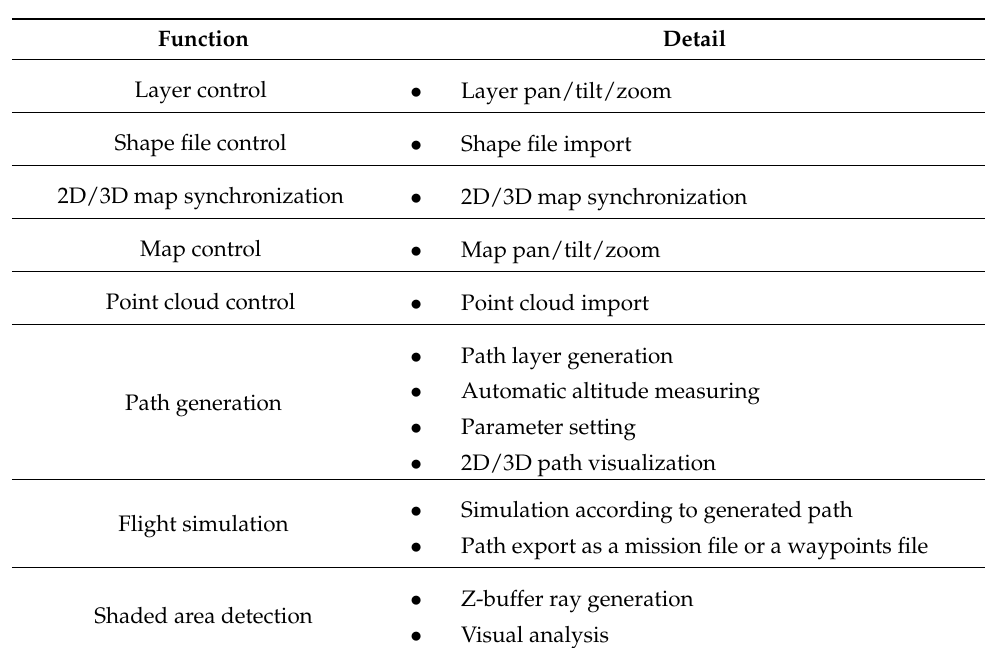
Figure 1. Development and validation process of this study. Table 1. Functions and details for the UAV photogrammetry